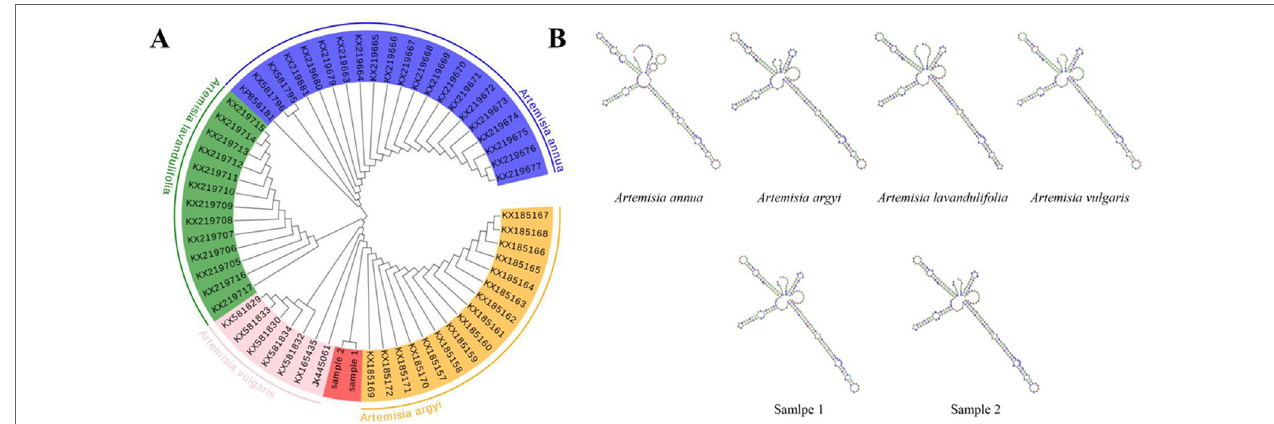
FIGURE 1 | Species identification of sample 2 by phylogenetic tree and ITS2 secondary structure. (A) Phylogenetic tree of the four Artemisia species constructed with the ITS2 sequences using the neighbor-joining (NJ) method; (B) ITS2 secondary